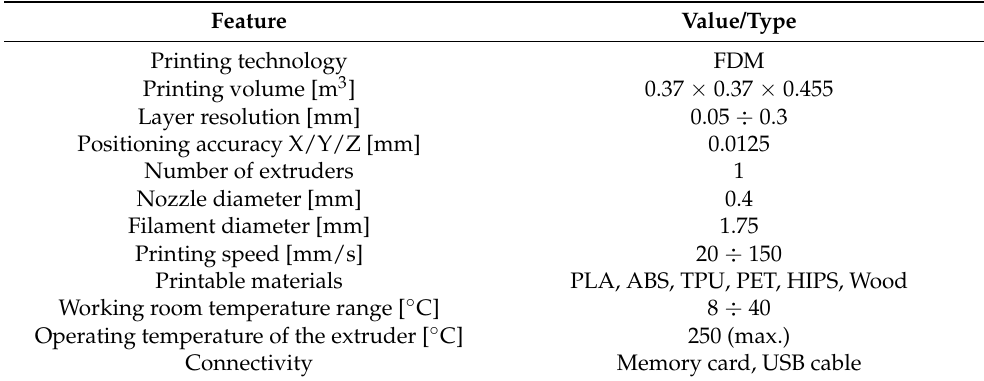
Table 4. Main features of the AnyCubic—Predator Delta FDM-based 3D printer used for the realiza- tion of the concept model made of PET.